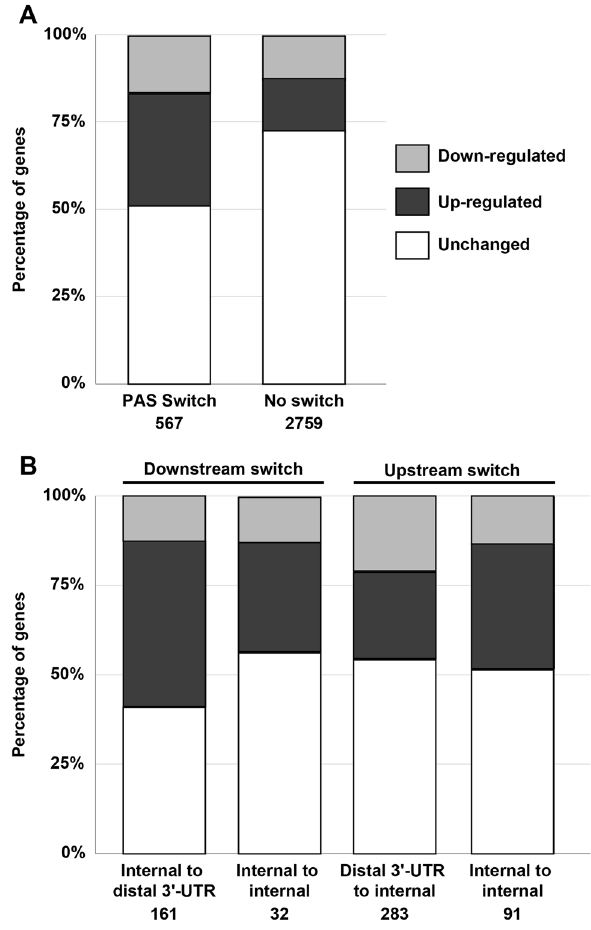
genes with or without a signi fi cant switch in PAS utilization ( a ) and in genes with upstream or downstream switches ( b ). The number of